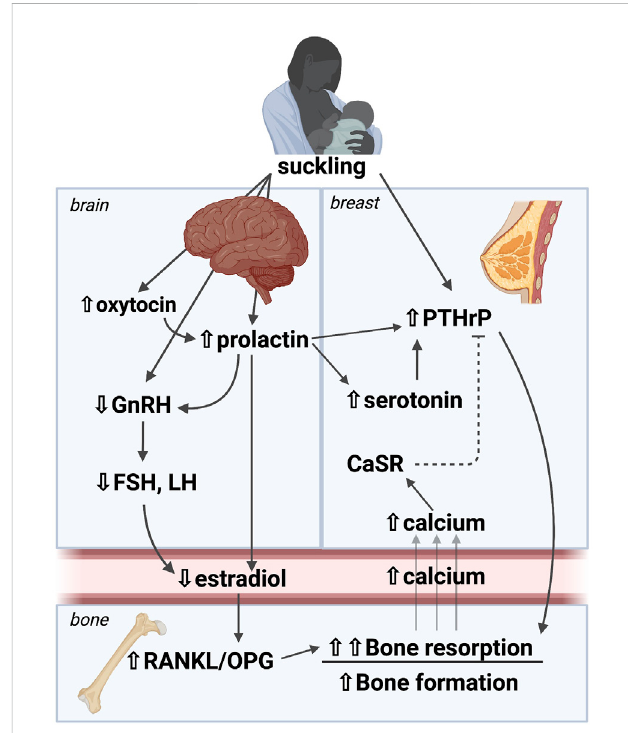
FIGURE 1 Abrain-breast-boneaxisregulatesskeletalandmineralmetabolism during lactation. Suckling stimulates afferent nerves from the mammary gland, which relay through the brainstem to the hypothalamus to inhibit GnRH production, and to stimulate prolactin and oxytocin secretion. The resulting hypogonadotropic hypogonadism leads to estrogen de fi ciency. The mammary gland secretes PTHrP into the circulation in response to suckling and increased circulating prolactin, effects that can be inhibited by stimulation of the calcium-sensing receptor (CaSR) by calcium delivery to the mammary gland. The combined effect of low estradiol and elevated PTHrP levels in lactation promote osteoclastic bone resorption as well as osteocytic osteolysis. These changes are the best studied to date, but they alone do not fully recapitulate the bone loss that occurs naturally with lactation, indicating that there are likely additional local or systemic factors that are involved in this process. PTHrP: Parathyroid hormone-related peptide, GnRH: Gonadotropic releasing hormone, FSH: Follicle stimulating hormone, LH: Leutenizing hormone, CaSR: Calcium sensing receptor, RANKL: Receptor activator of NF-KB ligand, OPG: osteoprotegerin. Image made with